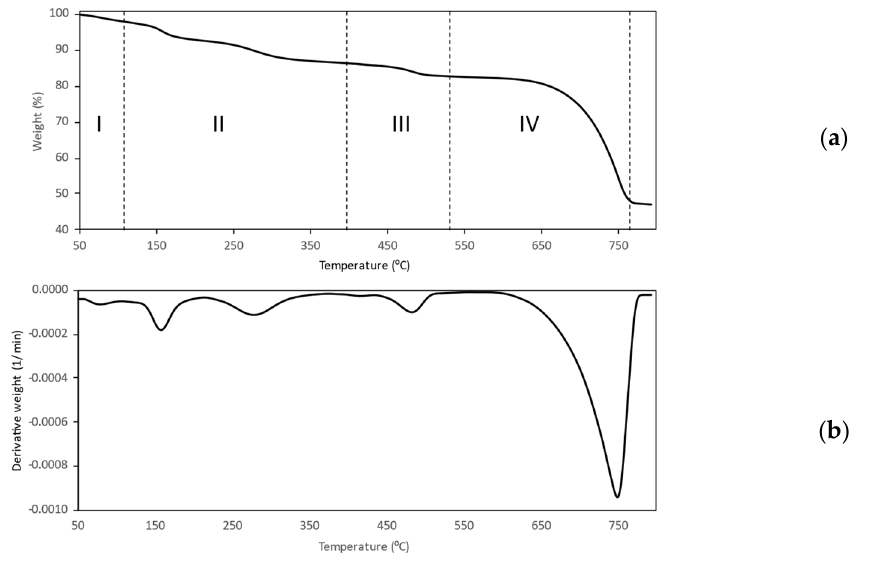
Figure 8. TG ( a ) and DTG ( b ) curves of dextran-coated nCPs (2g DEX).